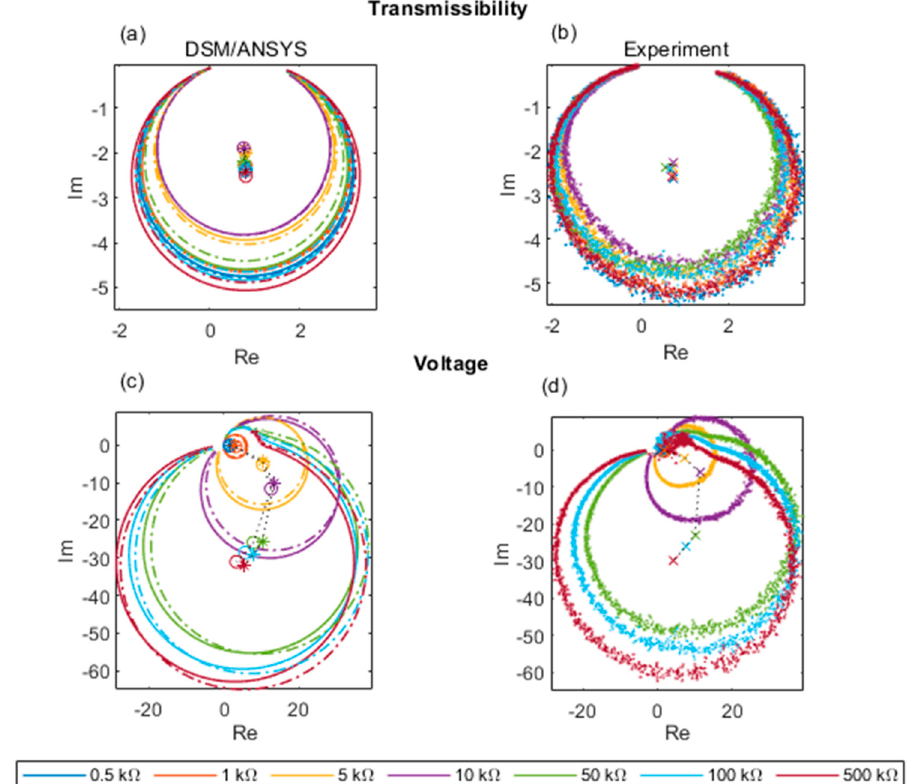
Figure 14. Nyquist plots of transmissibility FRF and voltage FRF for different electrical loads: ( a ) predicted transmissibility; ( b ) measured transmissibility; ( c ) predicted voltage FRF; ( d ) measured voltage FRF (dashed and solid lines in ( a , c ) represent data associated with ANSYS plane element model and DSM, respectively).